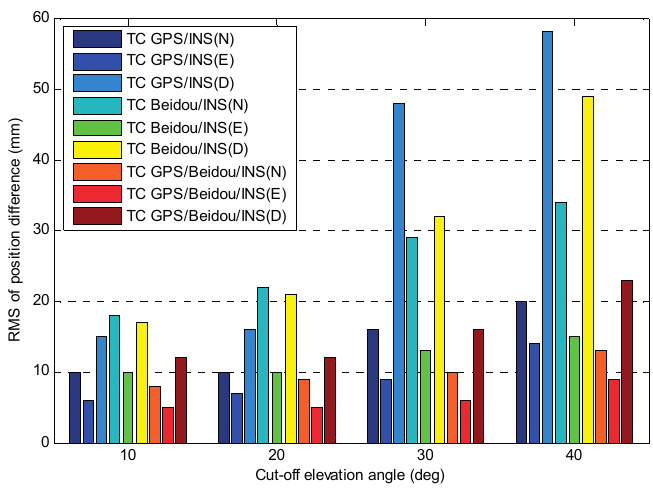
Figure 15. RMS of position difference vs. cut-off elevation angle for different system configurations. A comparison between GPS/BDS/INS integration solution and GPS/BDS fixed solution at 20° cut-off